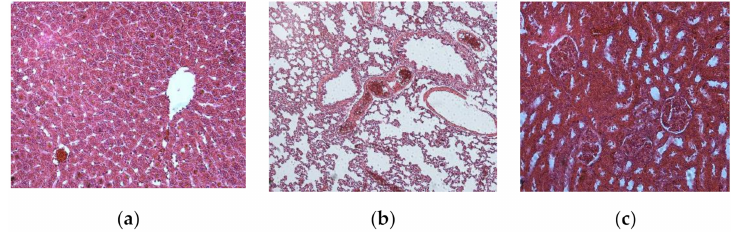
Figure 5. Morphology of the investigated organs for the ferulic acid-treated group: ( a ) liver normal morphology, col.HE, x20; ( b ) lung normal morphology, col.HE, x20; ( c ) kidney normal morphology, col.HE, x20.